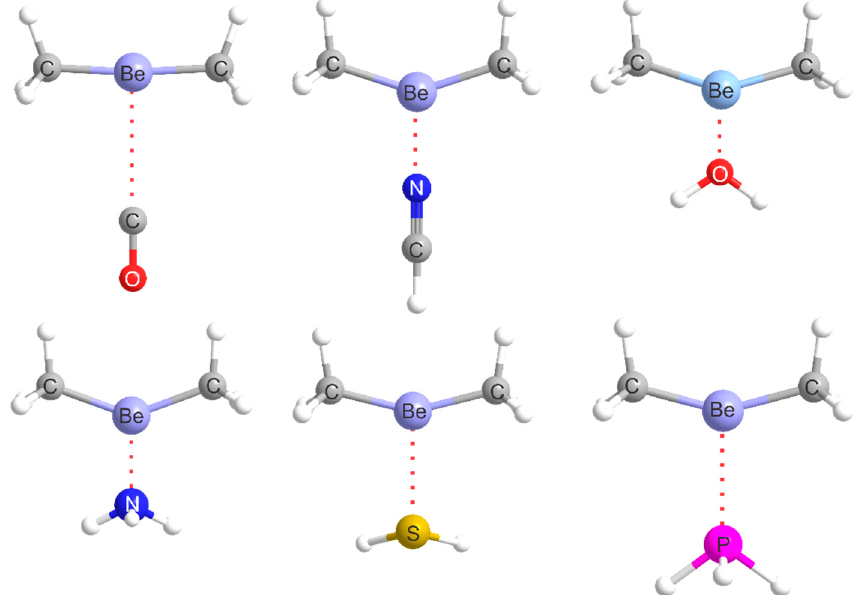
Figure 5. Geometries (drawn to scale) of six B ··· Be(CH 3 ) 2 complexes optimized at the CCSD(T)/aug-cc-pVTZ level of theory, where B = CO, HCN, H 2 O, NH 3 , H 2 S and PH 3 .